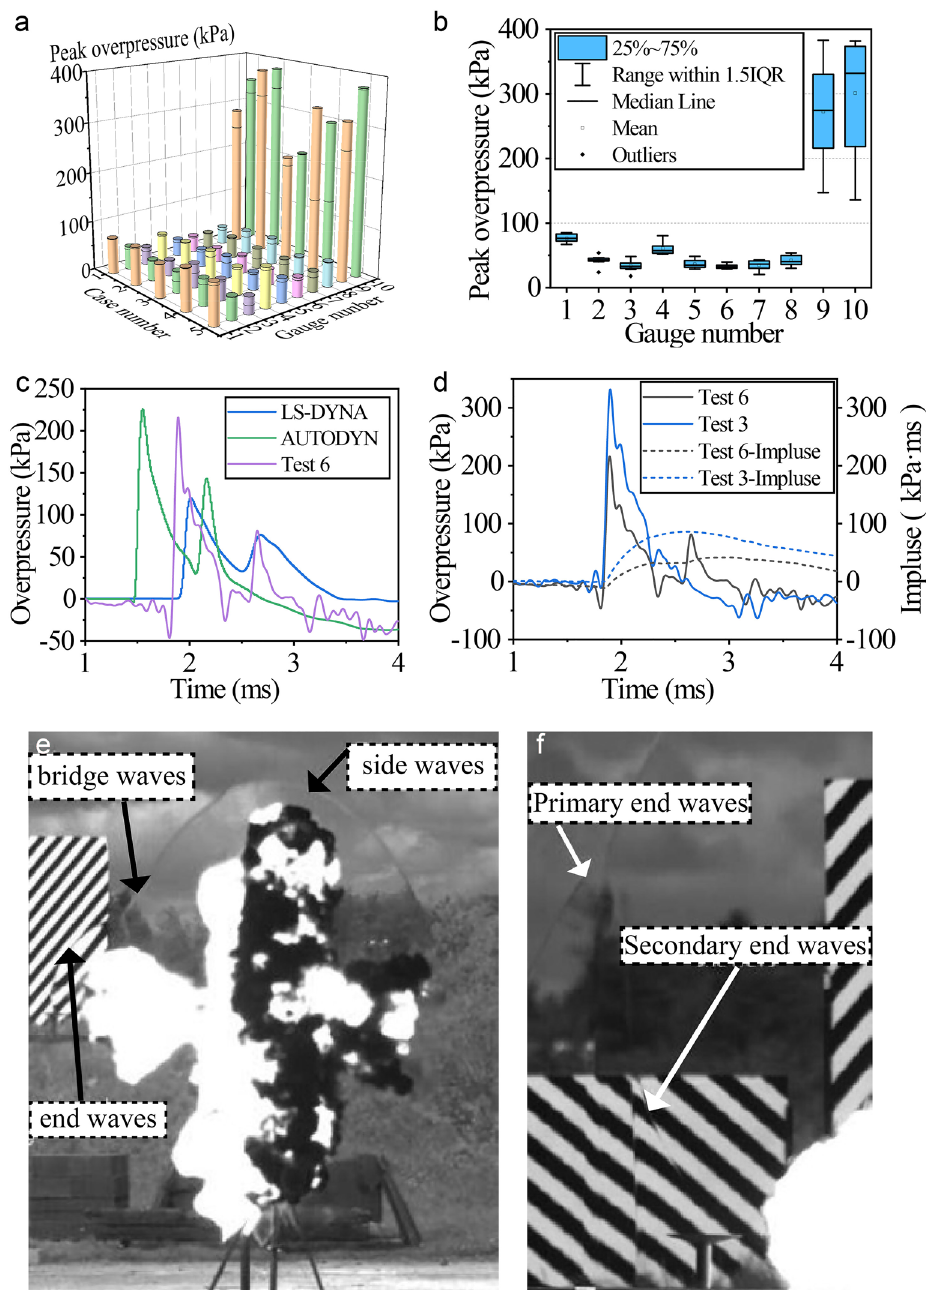
Figure 6. Variability analysis of blast loads. ( a ) Distribution of peak overpressures. ( b ) Statistical variability of peak overpressure. ( c ) Test and simulation results at Gauge 10. ( d ) Comparison of Case 3 and Case 2. ( e ) The detonation products and blast waves of cylindrical charges (0.459 kg at 3.6 ms) under air blasts (adapted from Ref. 37 ). ( f ) Primary end waves and secondary end